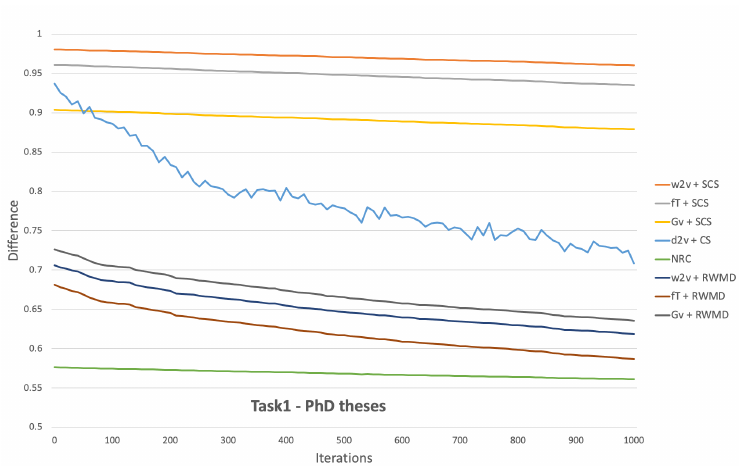
Figure 6. Task I–Ph.D. theses. We can see that most of the measures behave as expected, with a monotonic decrease. Only doc2vec seems to behave in an unexpected way, with those